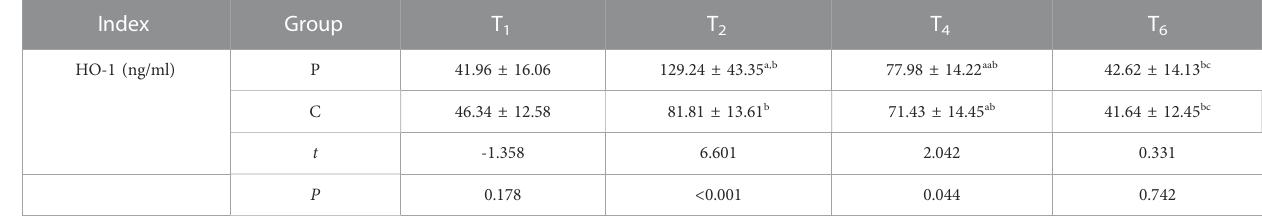
TABLE 2 Changes of HO-1 expression levels at different time points ( (cid:1) x ± s ) , n = 40).